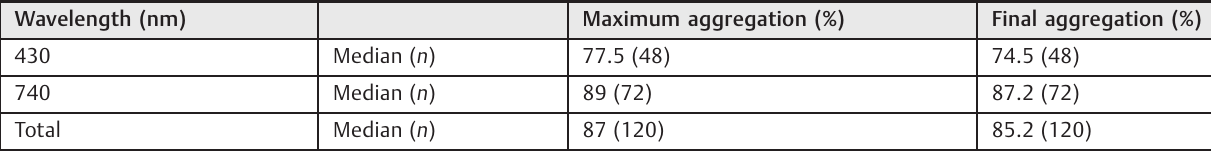
Table 5 Differences in the maximum and fi nal aggregation of all inductors based on the devices and wavelengths